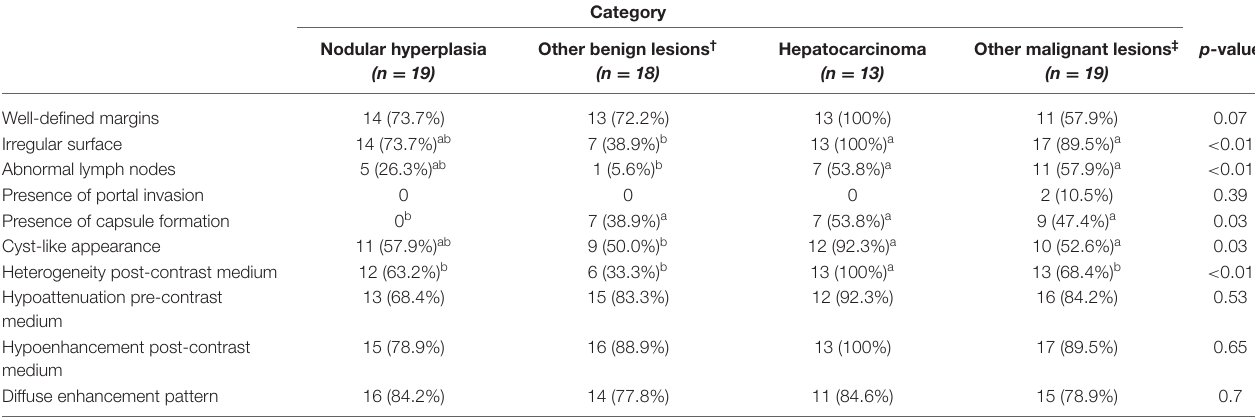
(quantitative features). TABLE 1 | Number of cases, classified based on cytological or histological examination, showing the qualitative features, along with the p -value.